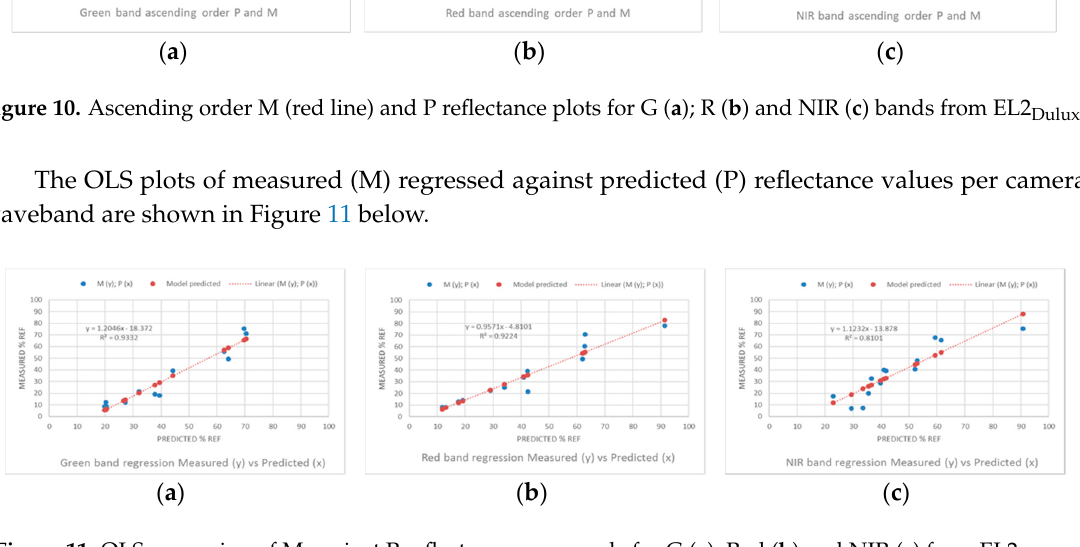
Figure 11. OLS regression of M against P reflectance per sample for G ( a ); Red ( b ) and NIR ( c ) from EL2 Dulux .